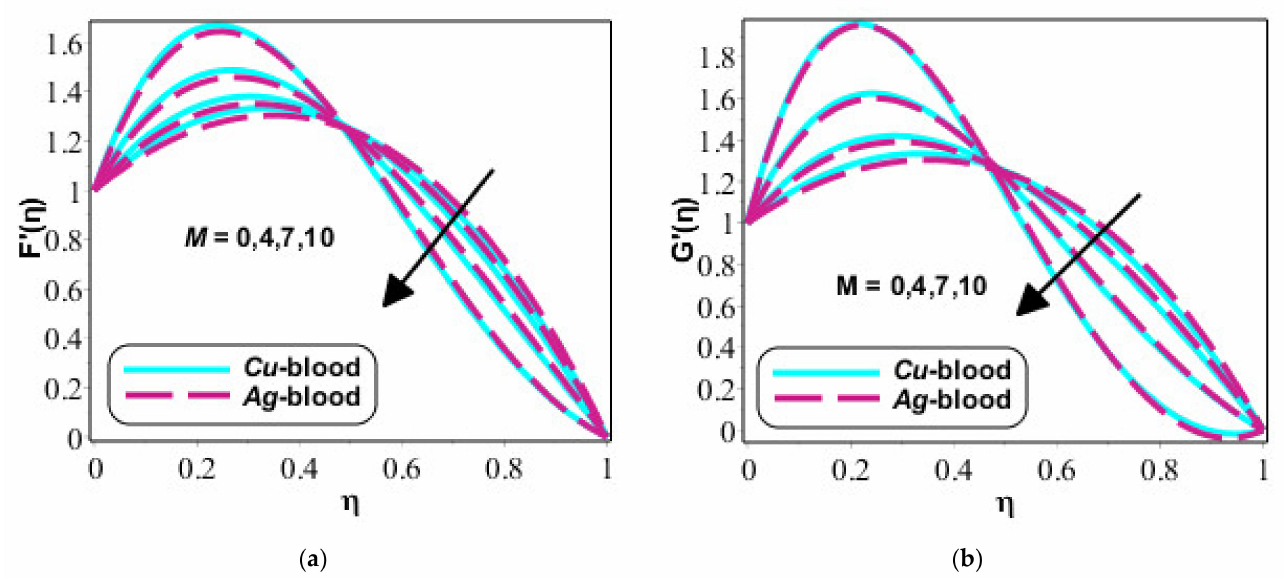
Figure 2. Behaviour of ( a ) F (cid:48) ( η ) and ( b ) G (cid:48) ( η ) as varying M when φ = 0.1, β i = 1.5, β e = 0.5, λ = 2, Re =